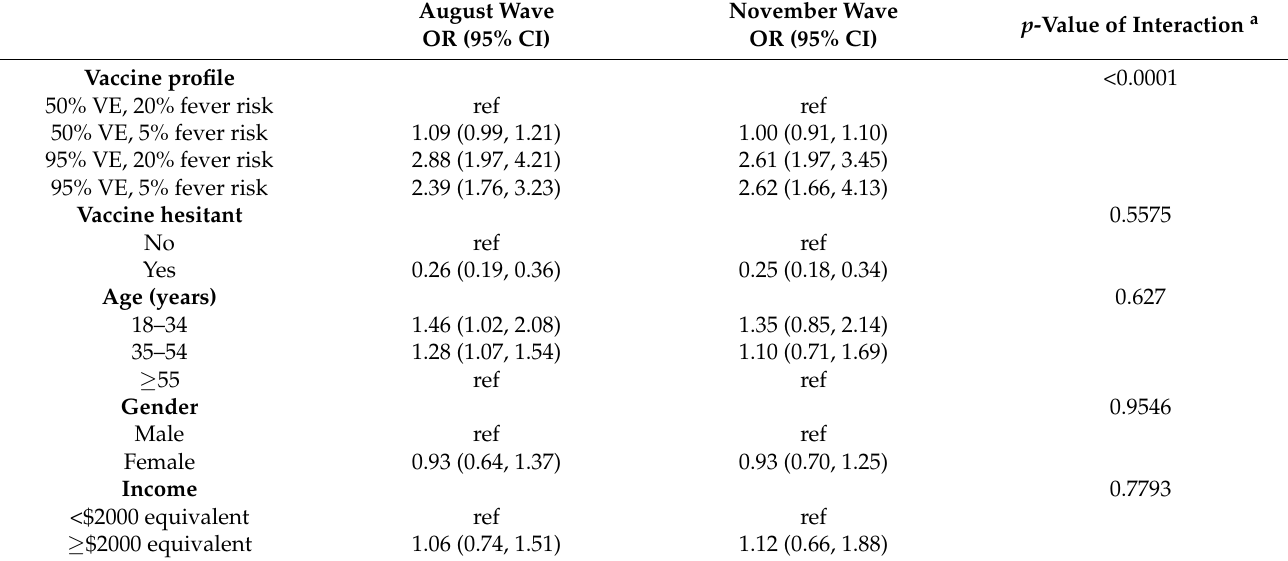
Table 3. Change in the effect of vaccine profile on vaccine acceptance between August and November, 2020, in six countries.